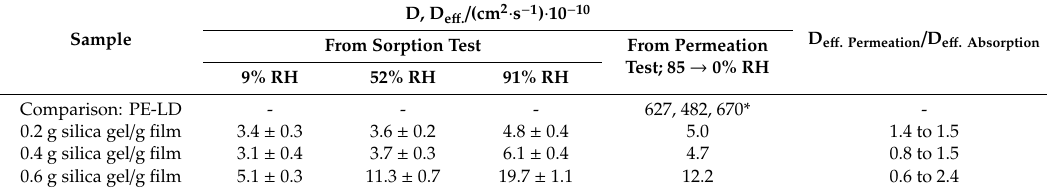
Table 3. Di ff usion coe ffi cient, D , of low-density polyethylene (PE-LD) [91] and e ff ective di ff